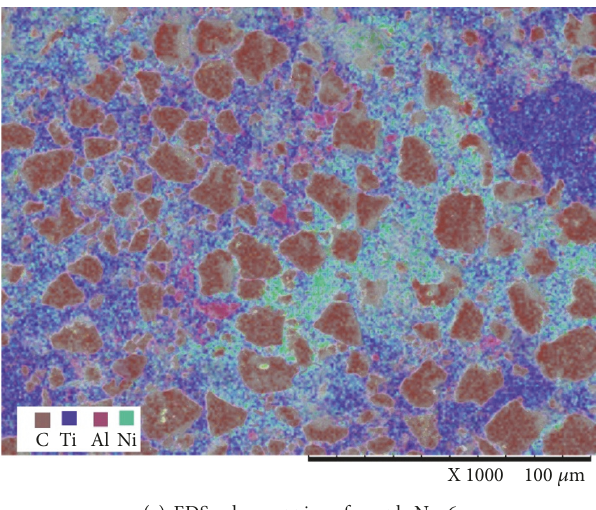
Figure 6: SEM micrograph of sample No. 6 (a) after SPS and (b) after impact-abrasive test (c) EDS color mapping.